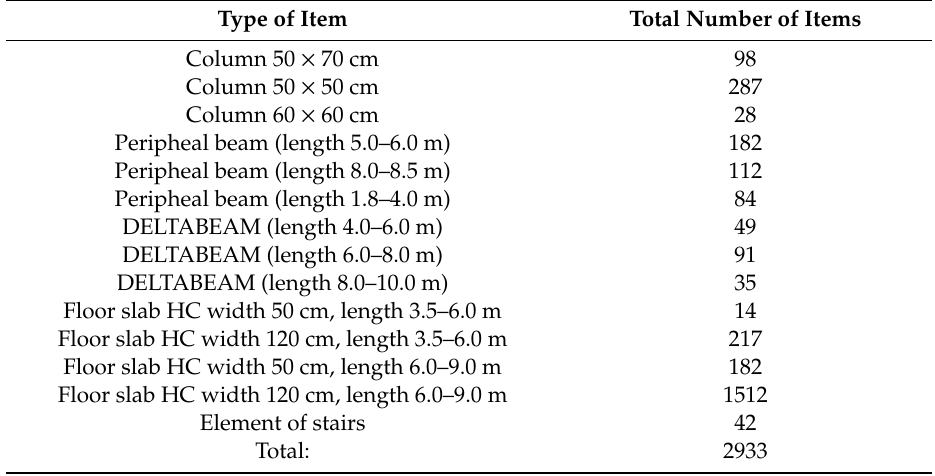
Table 1. List of reinforced concrete prefabricated elements to be mounted in the “Green2Day” building. Our own study based on the design by Grupa Projektowa Konstruktor Ltd. Type of